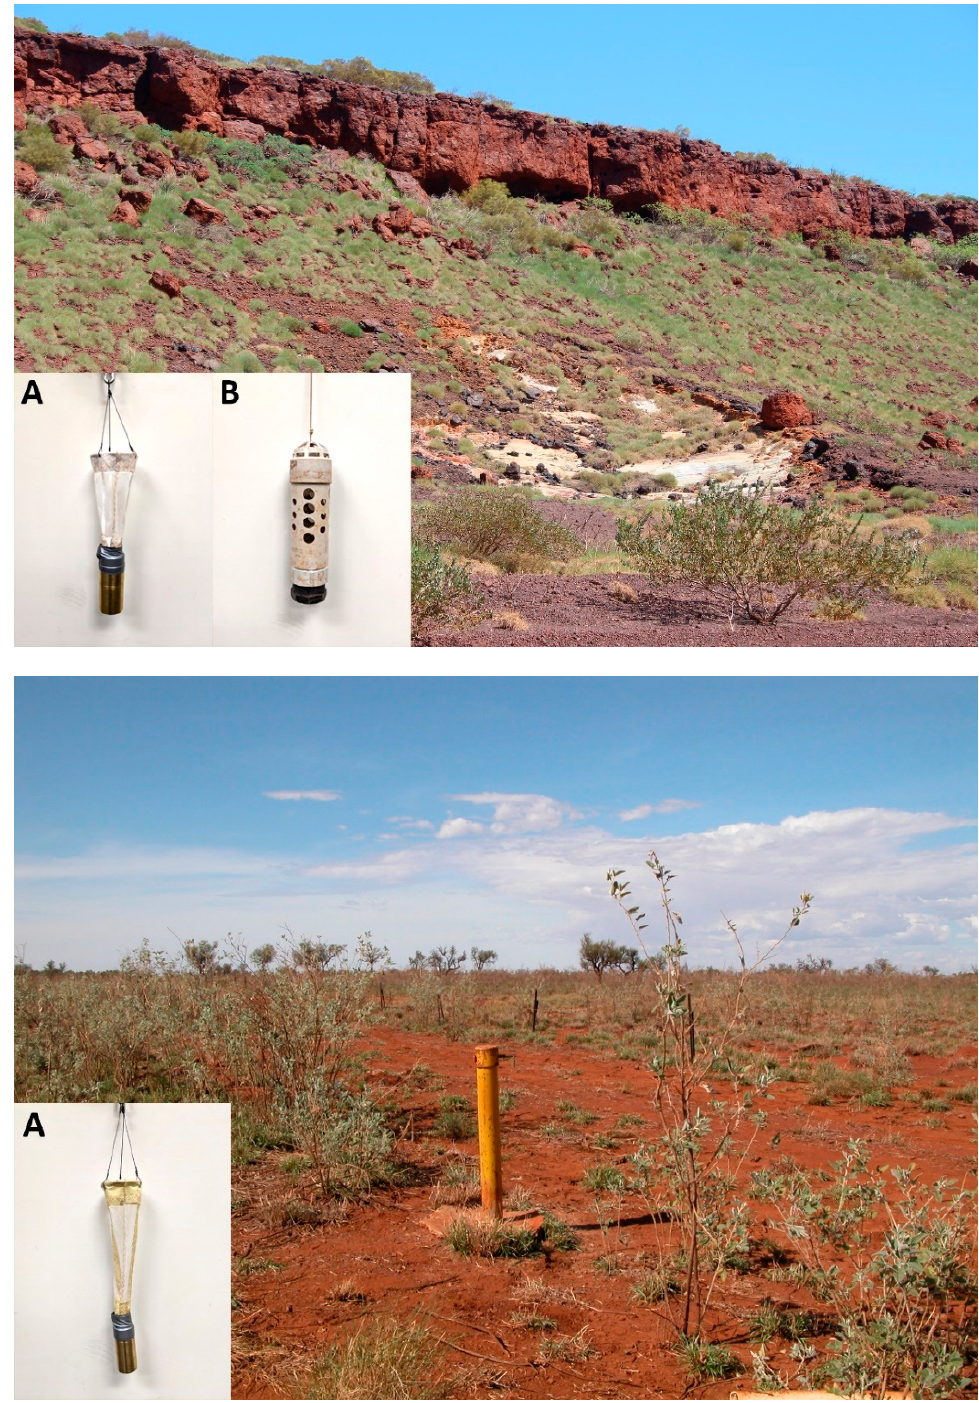
Figure 3. Upper panel, Mesa A, showing hardcap on top of the mesa; inset A, a scrape net; inset B, a troglofauna trap. Lower panel, Robe 2A well showing steel collar set in concrete; inset A, a stygofauna net. Photos by Claire Stephenson, Mike Scanlon and Melanie Fulcher.